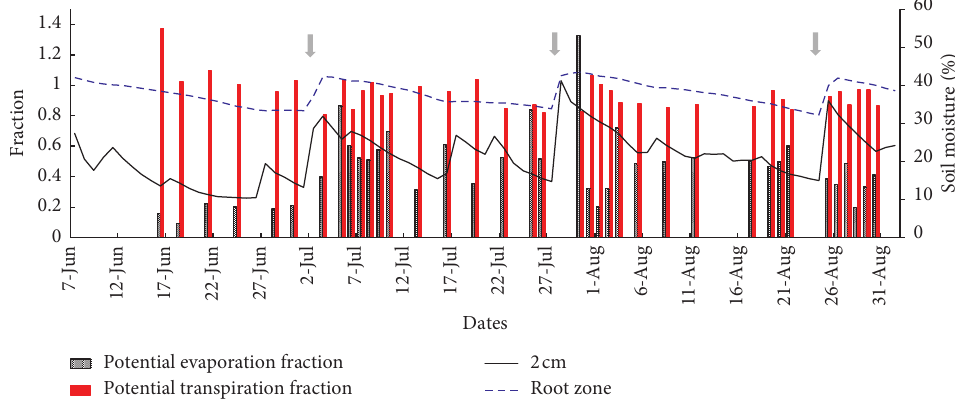
Figure 12: Potential evaporation and transpiration changes with observed multilayer soil moisture at the DM station. The three down arrows indicate three flood